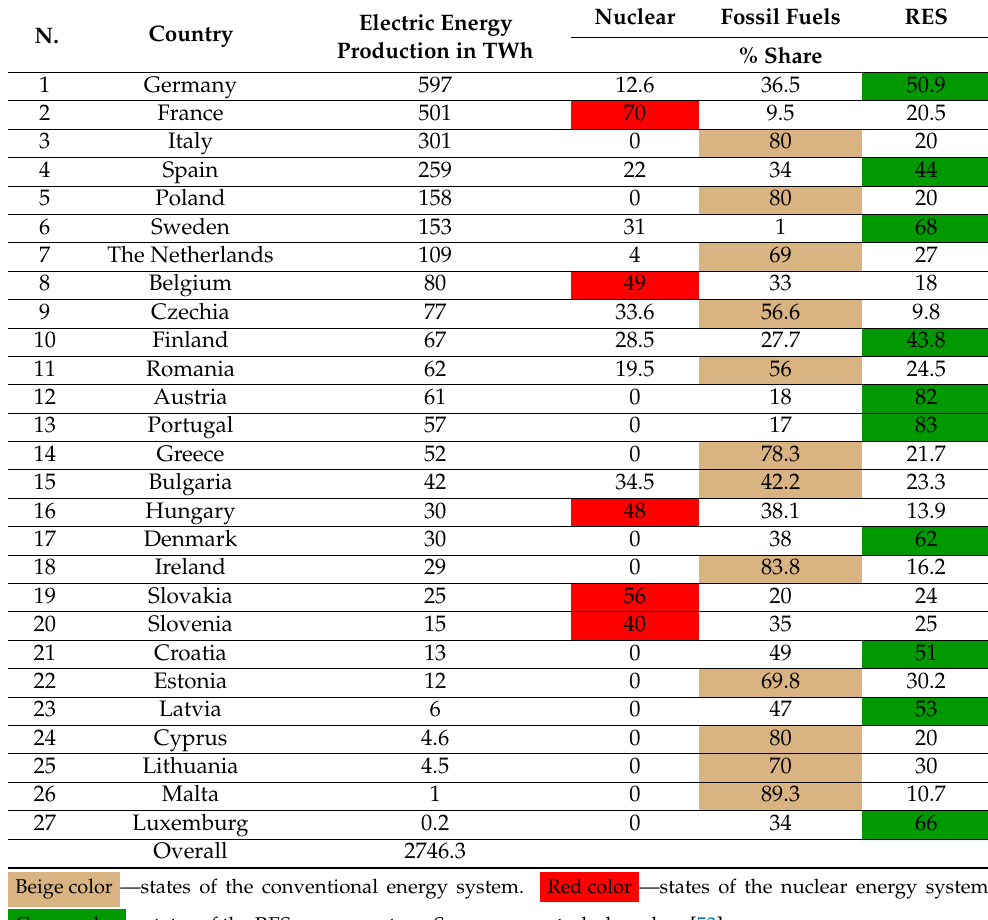
Table 2. List of electricity production data of EU countries at the end of 2021, with the indication of the dominant source.